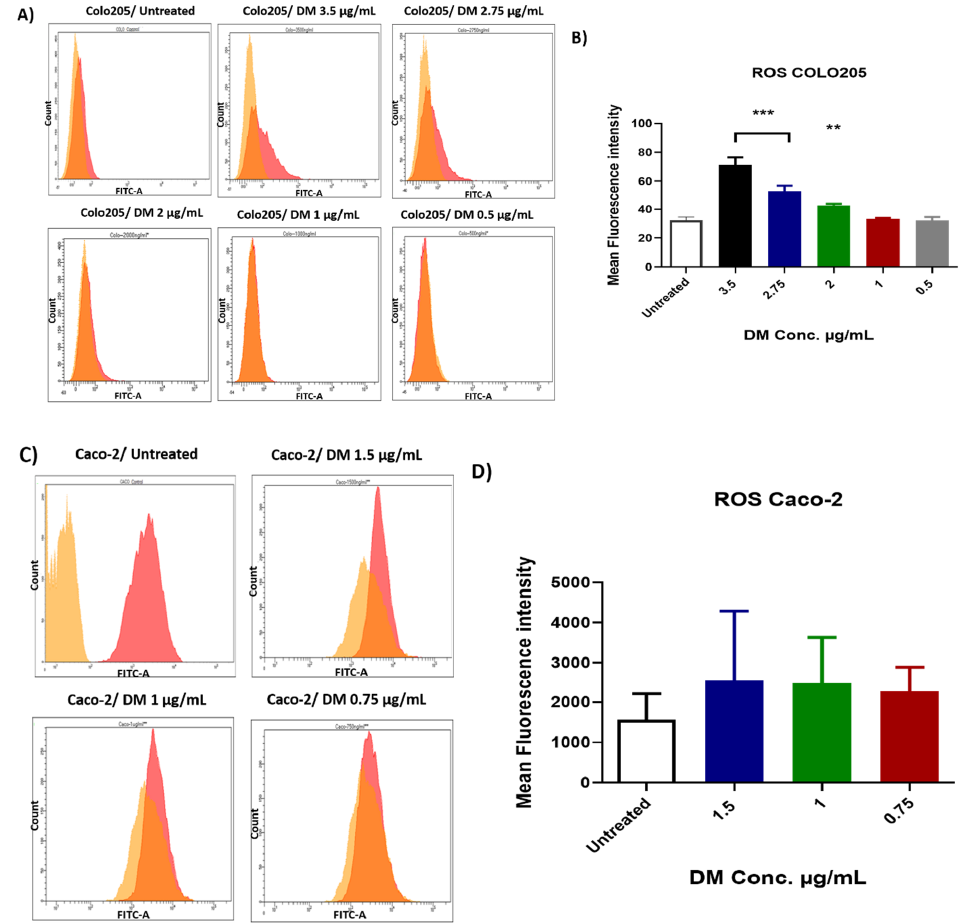
Figure 4. Production of reactive oxygen species (ROS) in COLO-205 and Caco-2 cells incubated for 48 h with D. maritima (DM) bulb extract: ( A , B ) Histograms and bar graphs of ROS production in COLO-205 cells were obtained by flow cytometer in the FITC channel in different groups. The bar graph shows a remarkable increase in the level of intracellular ROS in the treated group. ( C , D ) Representative histograms and bar graphs from Caco-2 cells treated with indicated concentrations of D. maritima extract on intracellular ROS levels production in comparison to control (untreated cells) detected by flow cytometer from three separate experiments (mean ± SD, n = 3). p-values ***<0.001, **<0.01.